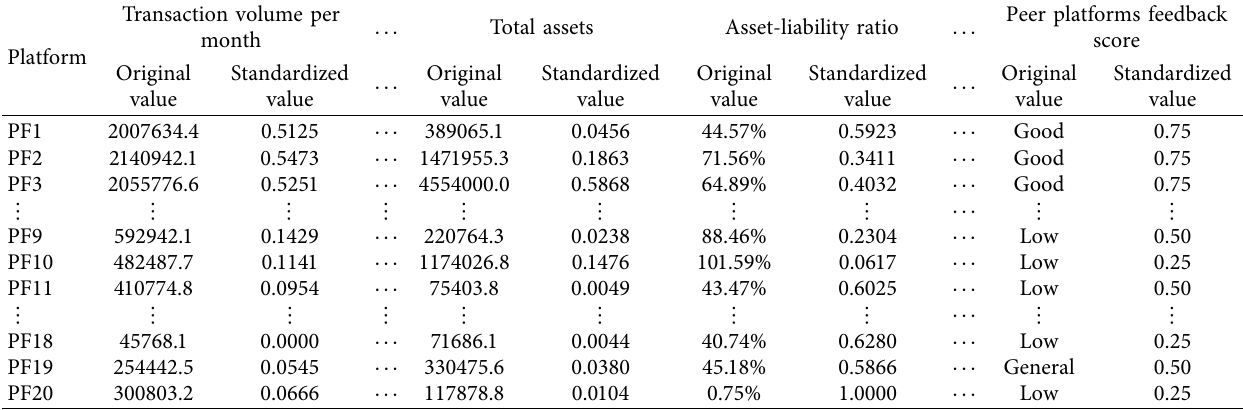
Table 6: The original and standardized data of 24 indicators of P2P lending platform.